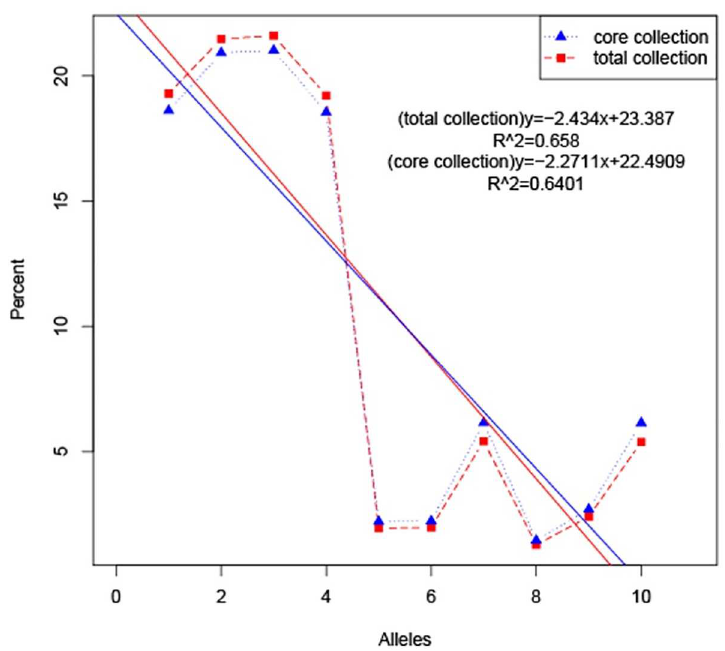
Fig 5. Comparison of the frequency of occurrence of alleles in the total collection versus the core set. The x-axis indicatedten alleletypes, (1) AA; (2) CC; (3) GG; (4) TT; (5) GT/TG; (6) AC/CA; (7) AG/GA; (8) CG/GC; (9) AT/TA; (10) CT/TC. The y-axis showedthe allelefrequencies.